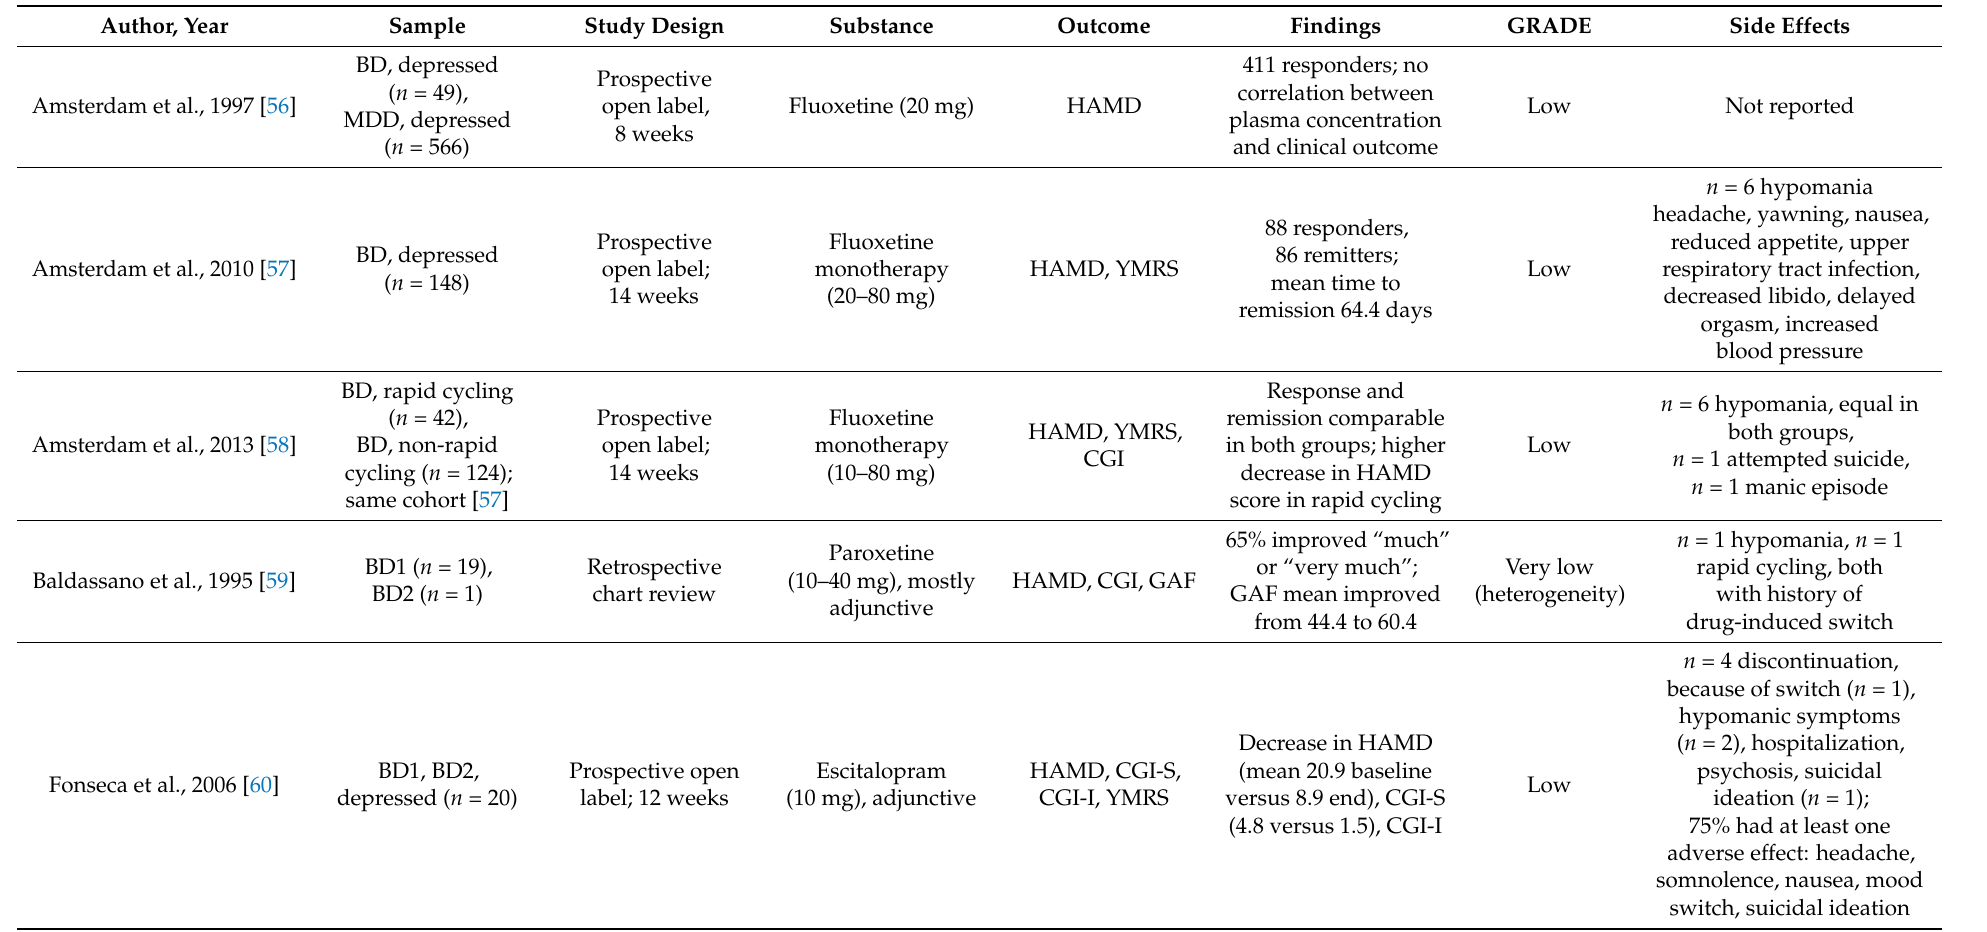
Table 3. Observational studies on antidepressants in the treatment of bipolar